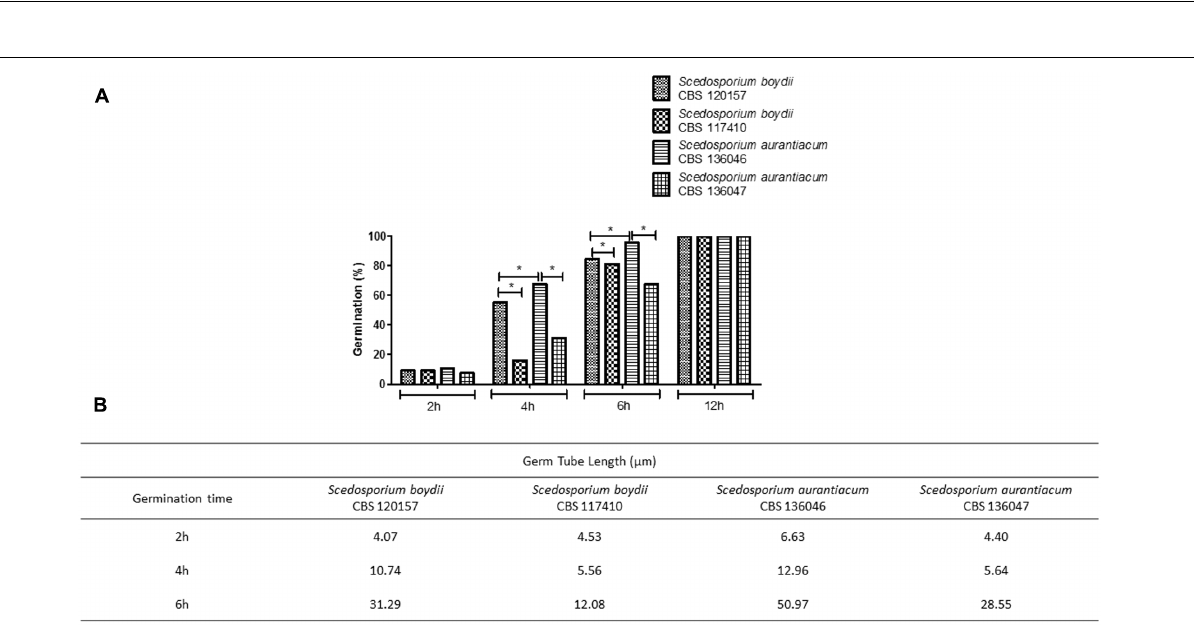
Frontiers in Microbiology |